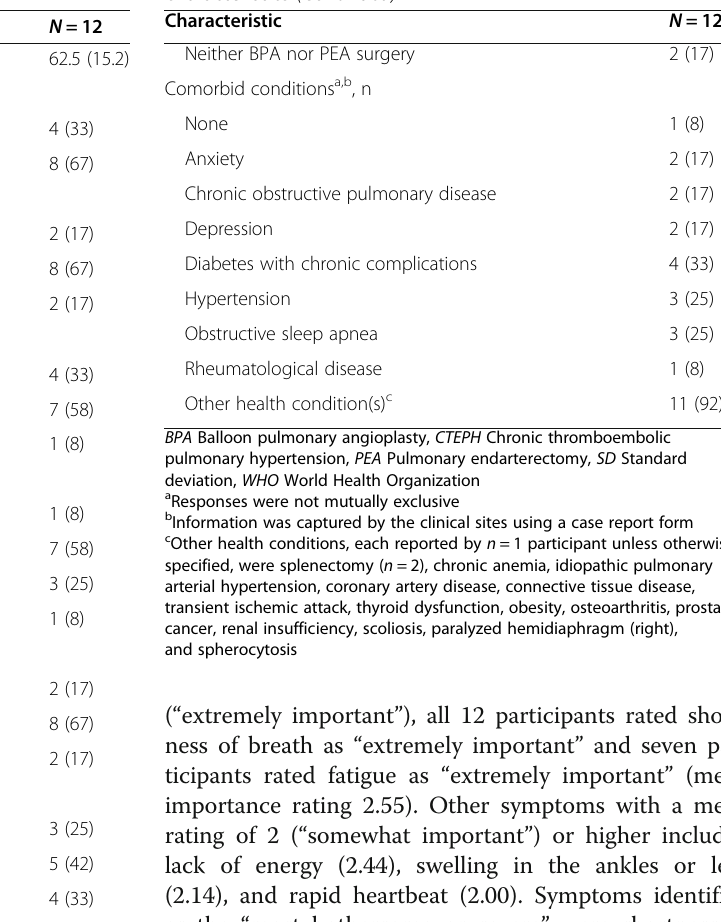
Table 1 Participant sociodemographic and clinical